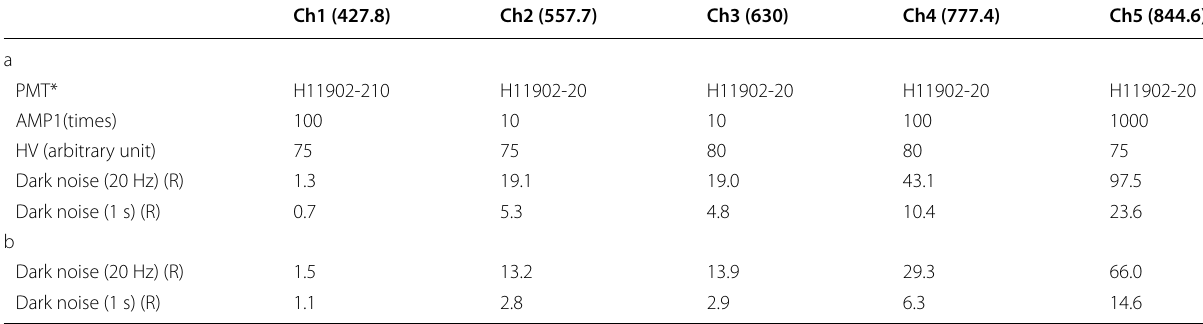
*Produced by Hamamatsu Photonics